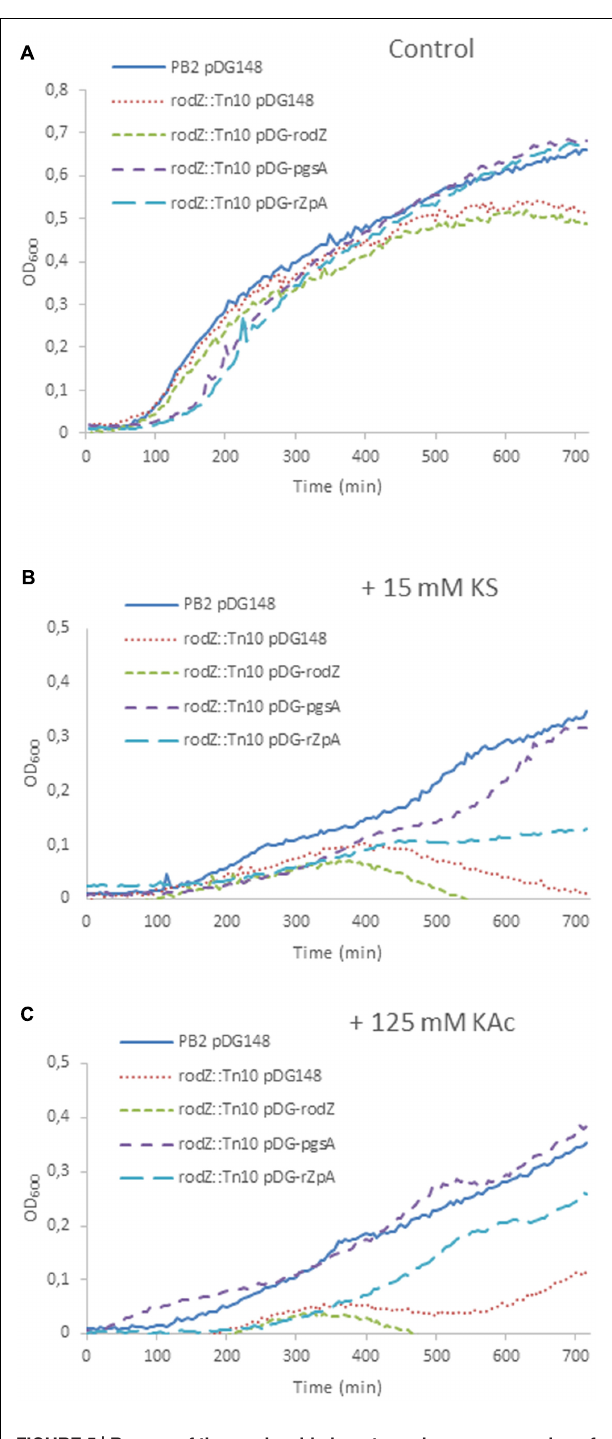
FIGURE 5 | Rescue of the weak acid phenotypes by overexpression of pgsA in the rodZ transposon mutant. Shown are growth curves of B. subtilis PB2 pDG148 (solid blue line) and rodZ ::Tn 10 , transformed with pDG148 (red dotted line), pDG- rodZ (green broken line), pDG- pgsA (purple broken line), and pDG- rodZ-pgsA (light-blue broken line) stressed without (A) , and with 15 mM KS (B) or 125 mM KAc (C) . 1 mM IPTG was added to the pre-cultures of all strains 3 h before the start of the experiments at t = 0 min. to induce